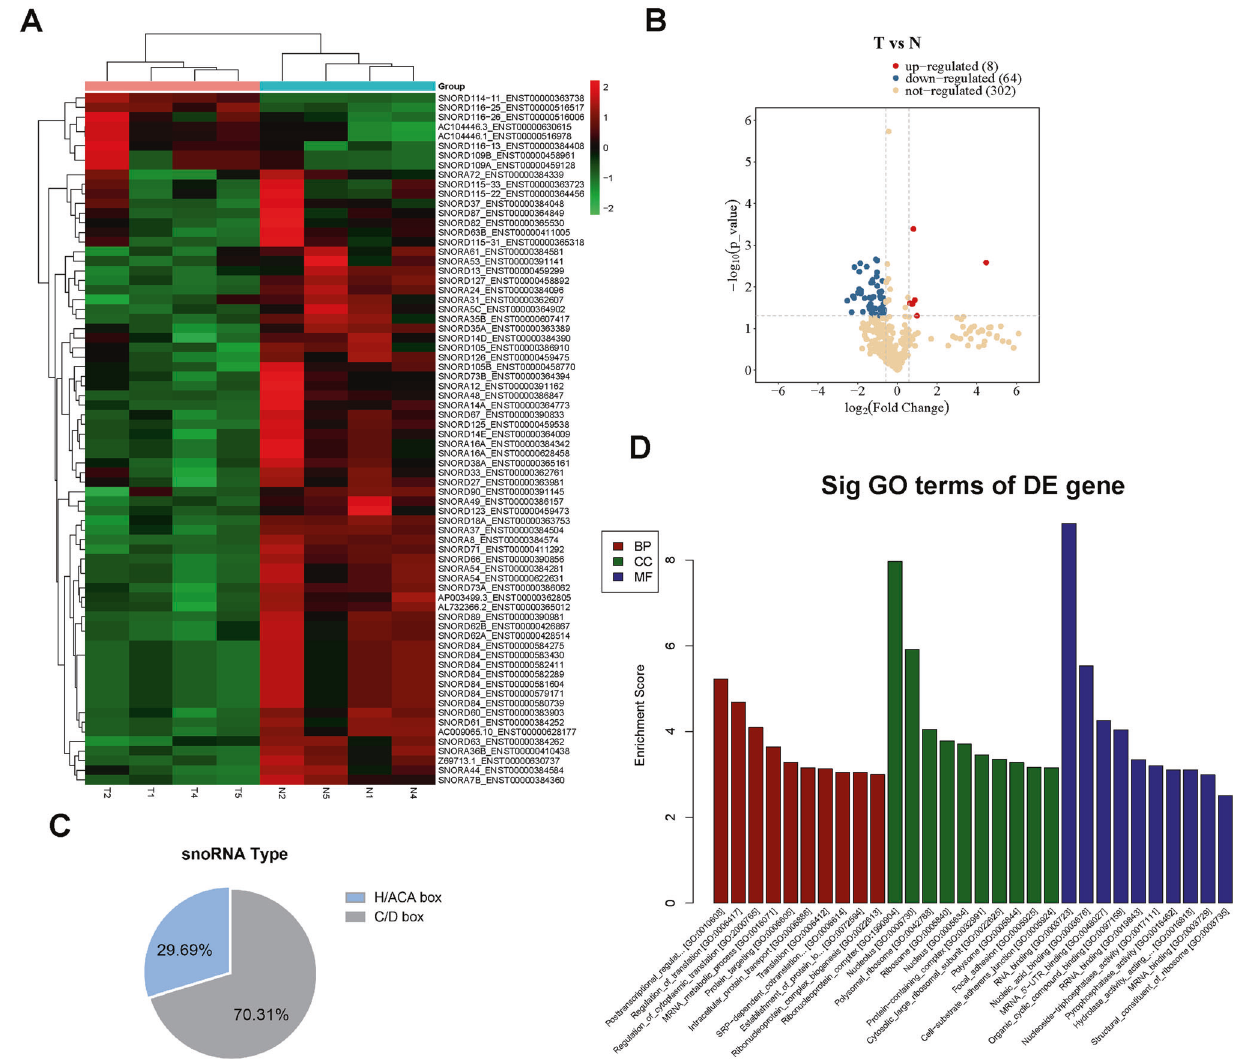
Fig. 1 SnoRNA sequencing reveals the snoRNA expression pro fi le of HB tissues. A Heatmap clustering of snoRNA sequencing results for 4 pairs of HB and NT tissues. B Volcano plot of signi fi cantly differentially expressed snoRNAs. C The types of signi fi cantly differentially expressed snoRNAs. D GO enrichment analysis of the host genes of signi fi cantly differentially expressed